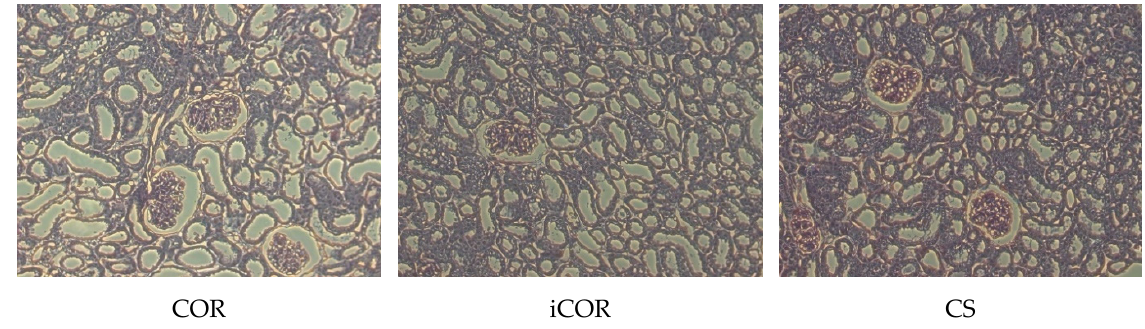
Figure 5. Representative sections of kidney tissue after reperfusion subsequent to preservation by either cold storage with controlled oxygenated rewarming (COR), instant controlled oxygenated rewarming (iCOR), or by cold storage without controlled rewarming (CS). PAS staining, 20× original magnification. Note the reduced tubular cell vacuolization and absence of necrosis in the groups COR and iCOR .